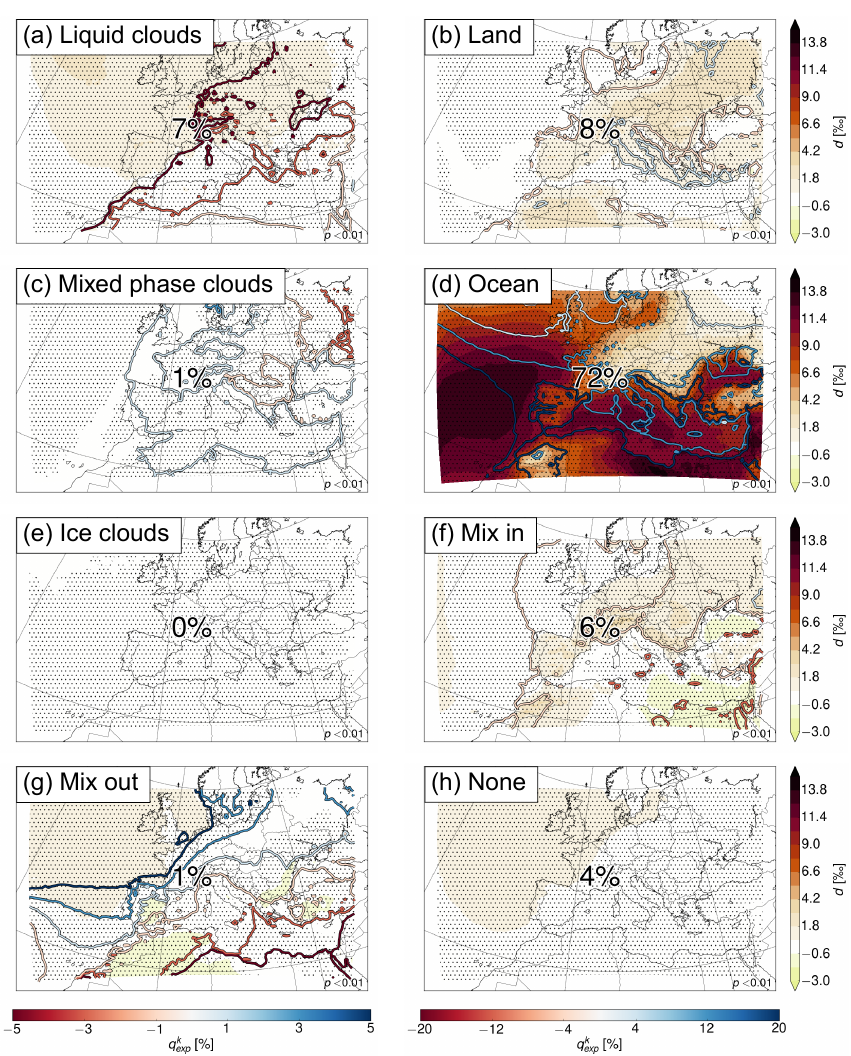
Figure 13. Contributions of the processes to the daily (cid:49)d in Fig. 12c. The contours show the difference in q k exp (see Eqs. 10 and 11) between the high and low anomaly days in %. Stippling indicates areas where p < 0 . 01. Note the different colour scales for q k exp between the left- and right-hand